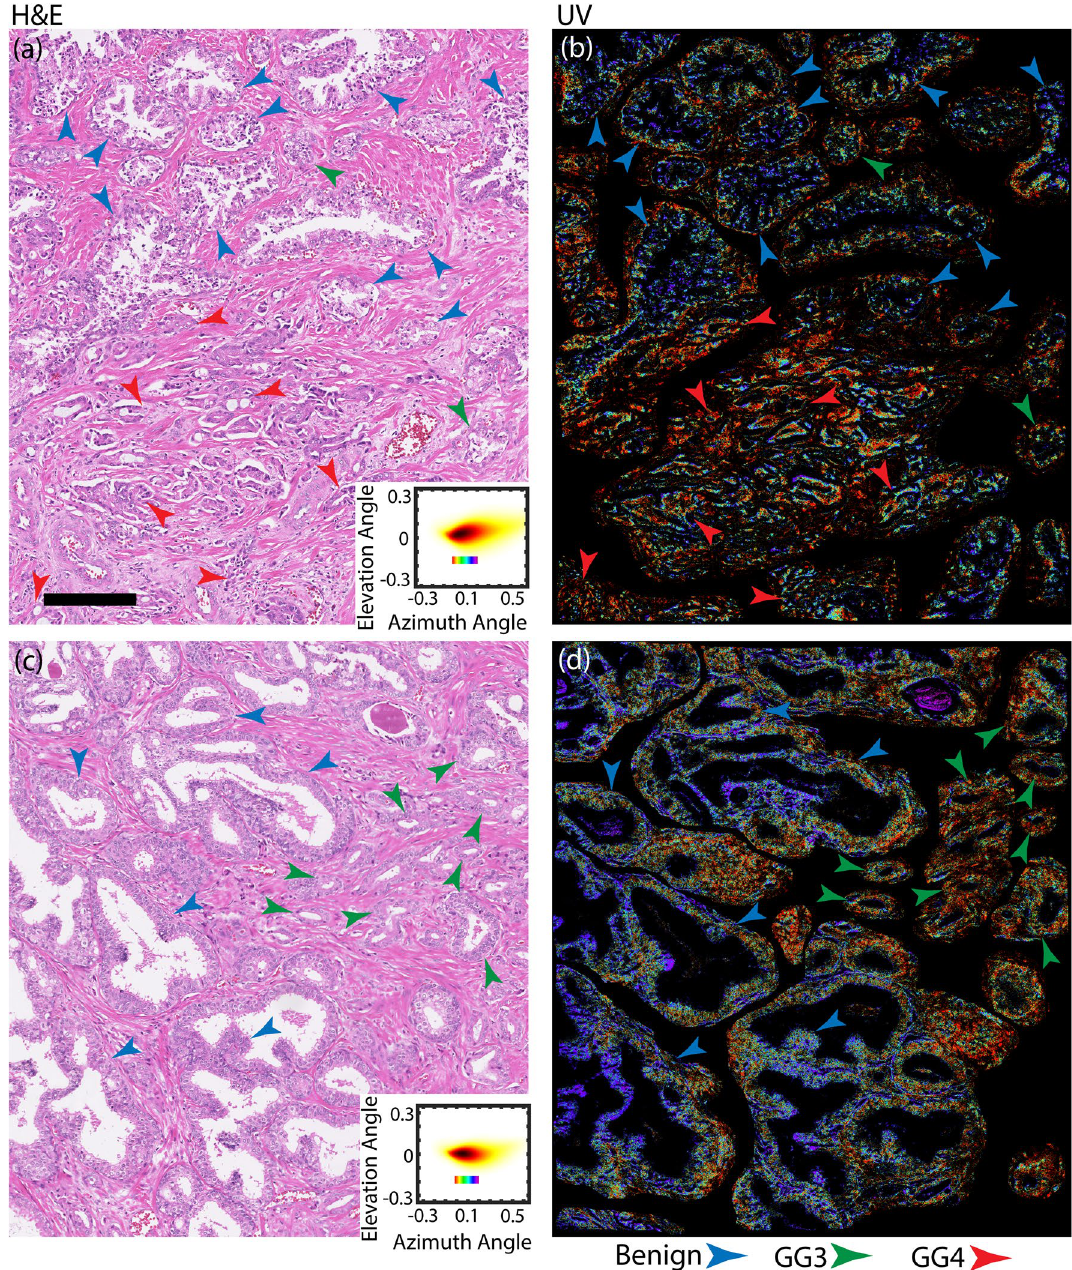
Figure 4. Comparison of malignancy maps from different prostate regions with corresponding H&E scans. Insets show the 2D histograms for comparison. As clearly evident from Fig. 4 the malignancy optical stain shows diagnostic capabilities complimentary to H&E, where only morphological parameters are considered. In ( b and d ) we have manually removed stroma and inflammation regions to aid visibility. The cell-size red regions on the edges of the glands are originating from two sources: 1-ill-formed fused type Gleason Grade 4 regions have spread around benign glands and in fact it is an indicative of existence of cancer. These regions are sometimes missed by pathologists in H&E analysis 2- Existence of inflammation cells that were impossible to remove with manual segmentation. These inflammation cells are limited in number and do not contain any diagnostically important information and they are mostly in stromal region. (Scale bar: 200